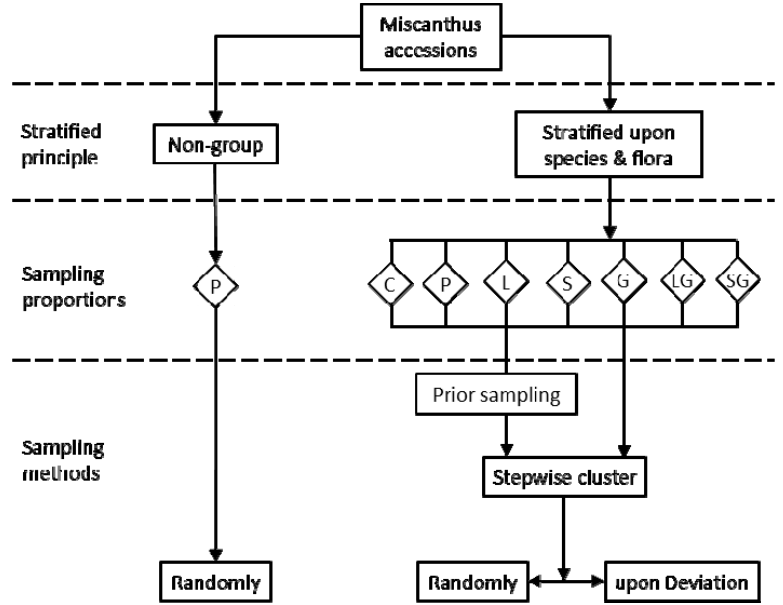
Figure 1. Sampling schemes of developing Miscanthus primary core collection. Constant strategy (C), Proportional strategy (P), Logarithm strategy (L), Square root strategy (S), Genetic diversity